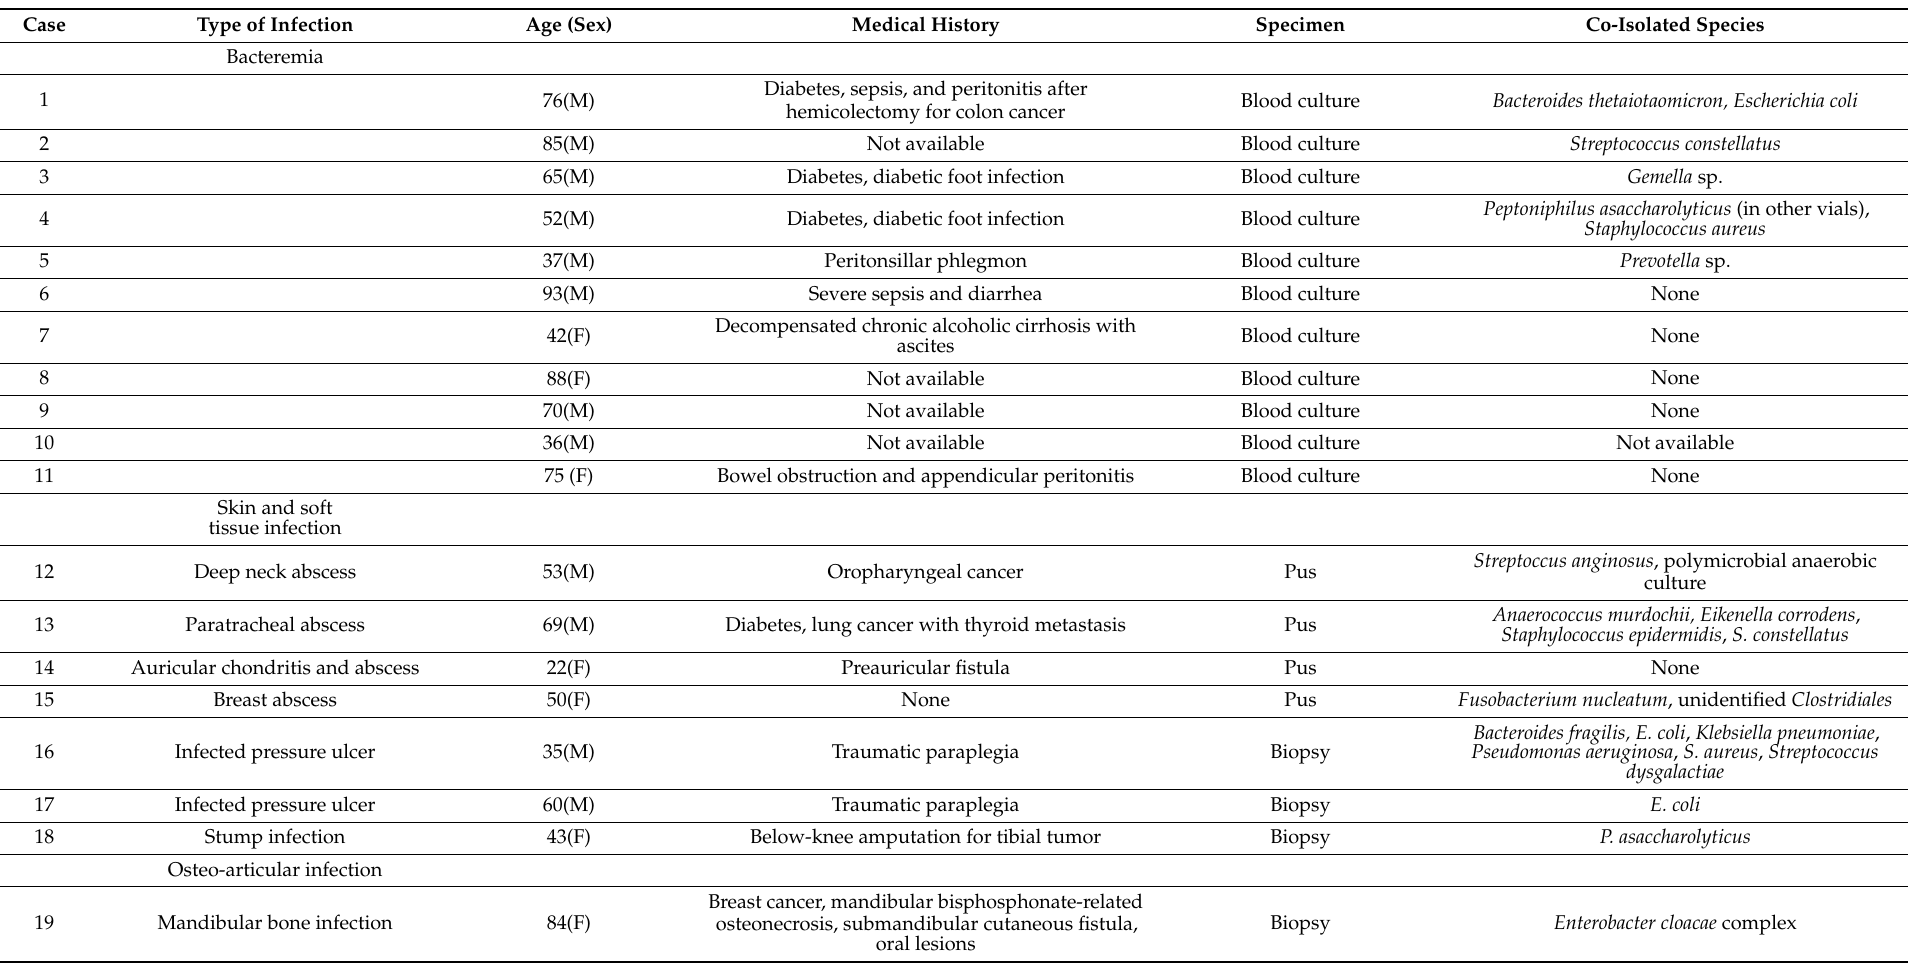
Table 1. Data for the 27 Solobacterium moorei cases with available data included in this